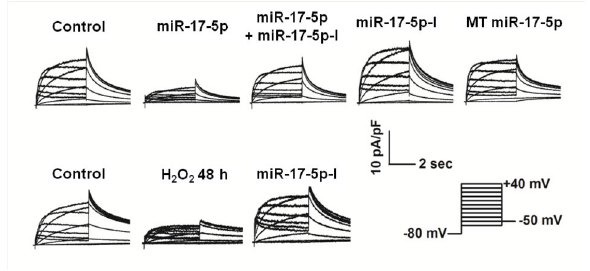
Figure 6. Effects of miR-17-5p on h-ERG current (I recorded using whole-cell patch-clamp techniques. The voltage protocol was shown in the inset. miR-17-5p-I: miR-17-5p inhibitor (co-transfected with miR-17-5p mimic); MT miR-17-5p: mutant miR-17-5p. Similar results were observed in another 7 cells for each case.